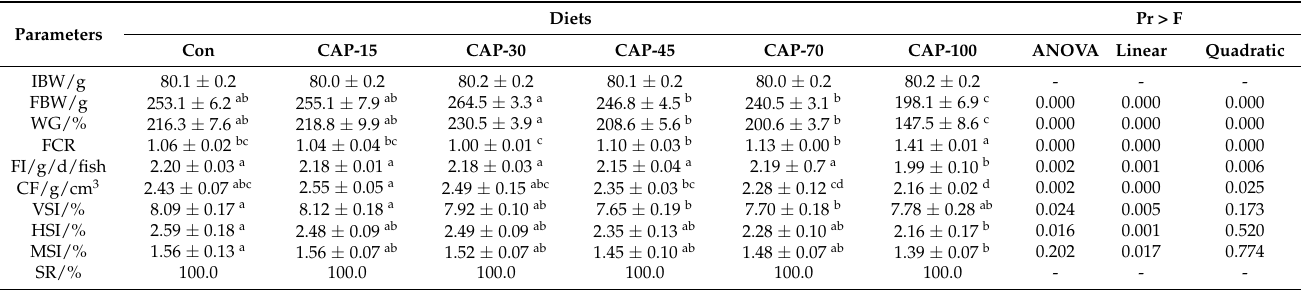
Table 4. Effects of dietary Clostridium autoethanogenum protein on growth and body index of large- mouth bass.